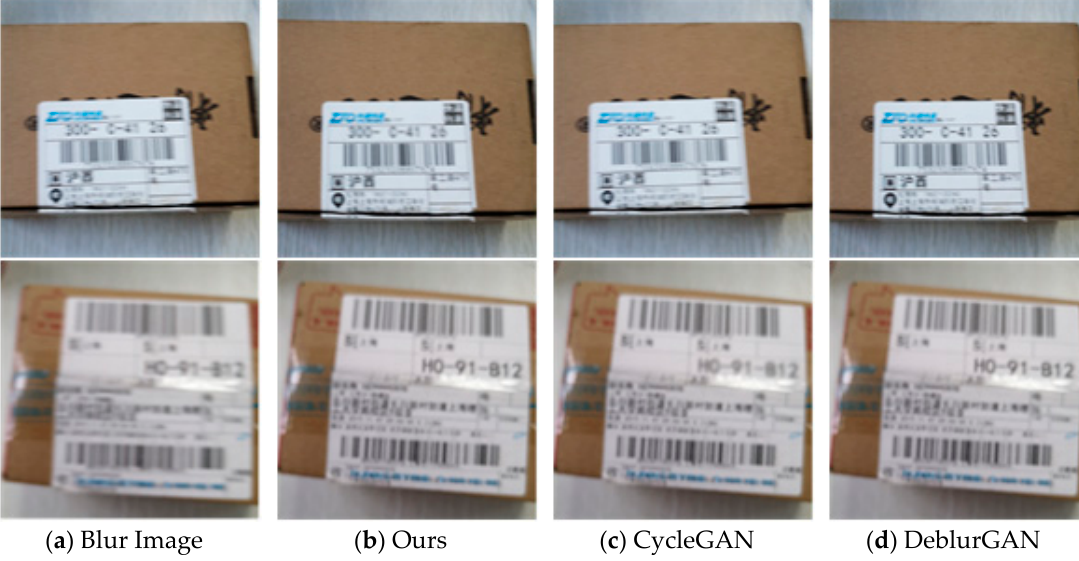
Figure 11. Experimental results of different algorithms on unpaired dataset.